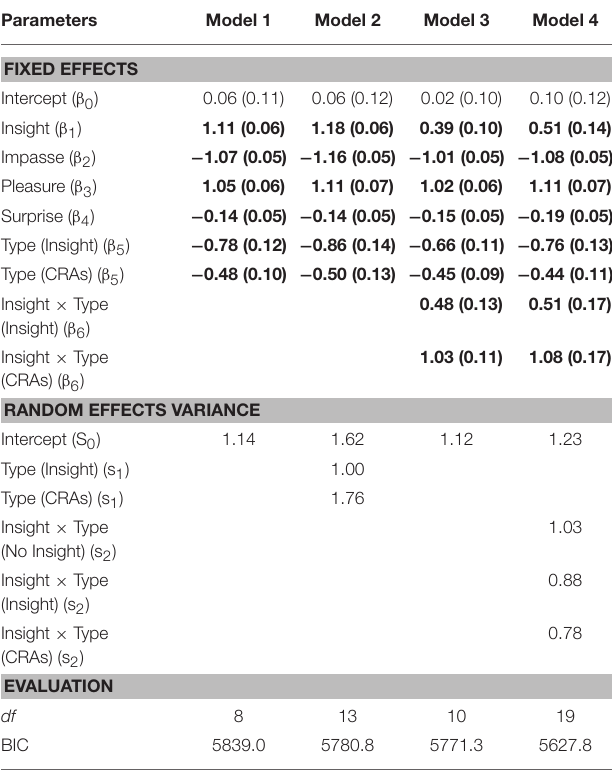
TABLE 2 | Estimated parameters (and standard errors) of multilevel